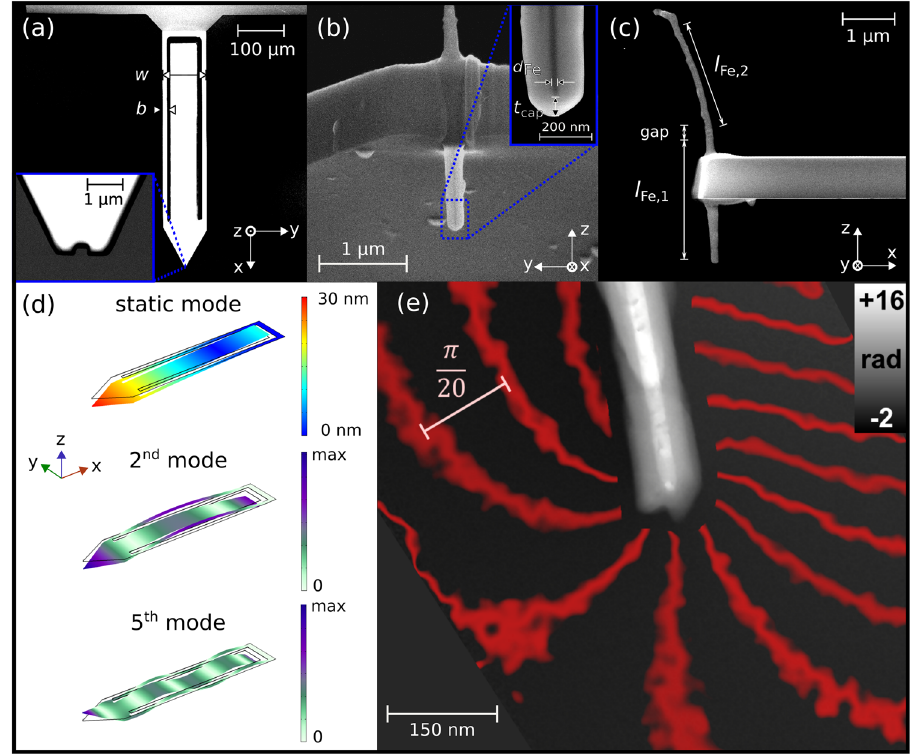
Fig. 6 Sensor for magnetic fi eld and fi eld gradient microscopy. a Scanning electron microscopy (SEM) top view of the customized cantilever. The receptacle for the subsequent nanowire (NW) attachment is shown in the inset. b SEM micrograph of the magnetic NW attached to the cantilever free end. In the inset, the iron nanowire (FeNW) contained in the carbon nanotube is visible. The diameter d Fe of the FeNW and the non-magnetic cap thickness t cap are indicated. c SEM side view of the sensor ’ s free end disclosing the full NW length. The 275 nm gap splits the FeNW into two parts with corresponding lengths l Fe ; 1 and l Fe ; 2 . d COMSOL beam shape simulations of static bending caused by an applied tip load of F z ¼ (cid:4) 100 pN and for the 2nd and 5th fl exural oscillation modes. The colors describe the absolute value of the de fl ection. e Magnetic induction ( B - fi eld) mapping of a typical iron- fi lled carbon nanotube (FeCNT) obtained from a phase image reconstructed by off-axis electron holography in the transmission electron microscope. The red iso-lines in steps of π ⁄ 20 display the projected stray- fi eld lines around the FeCNT, which is visualized as greyscale phase